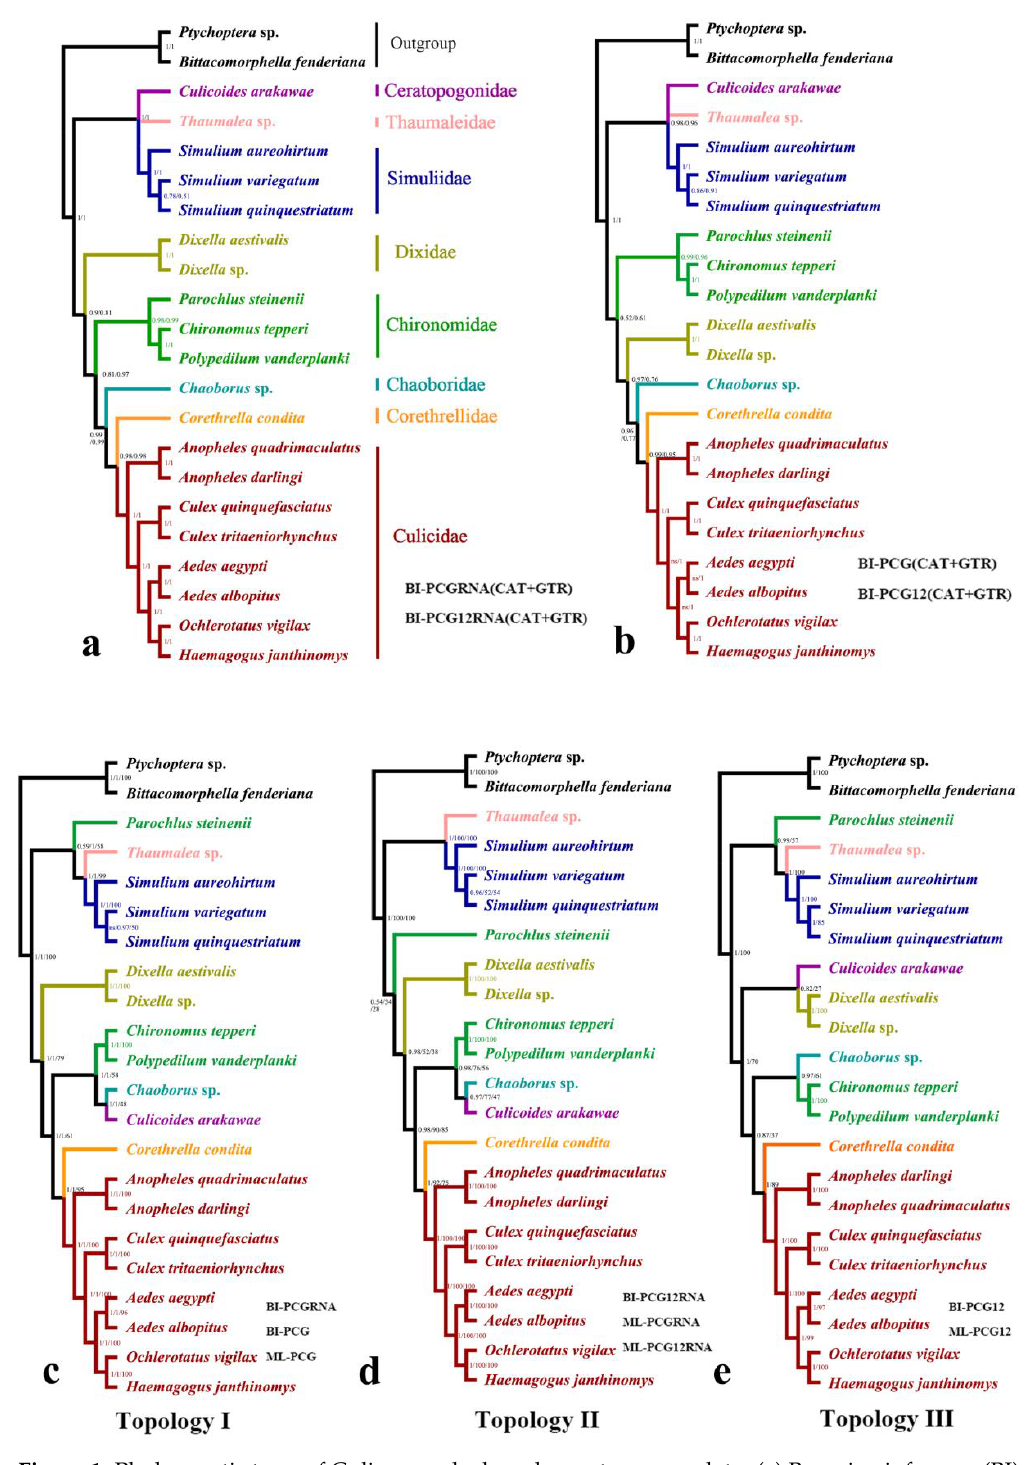
Figure 1. Phylogenetic trees of Culicomorpha based on mt genome data. ( a ) Bayesian inference (BI) tree based on protein-coding gene (PCG) 19 tRNAs and two rRNAs (RNA) and PCG12RNA with heterogeneous models (CAT + GTR); ( b ) BI tree based on PCG and PCG12 with heterogeneous models; ( c ) BI tree based on PCGRNA and PCG, and ML tree based on PCG with homogeneous models; ( d ) BI tree based on PCG 12RNA and ML tree based on PCGRNA and PCG12RNA with homogeneous models; ( e ) BI and ML tree based on PCG12 with homogeneous models. Numbers above the branches are posterior probabilities or bootstrap percentages, ns = not support.